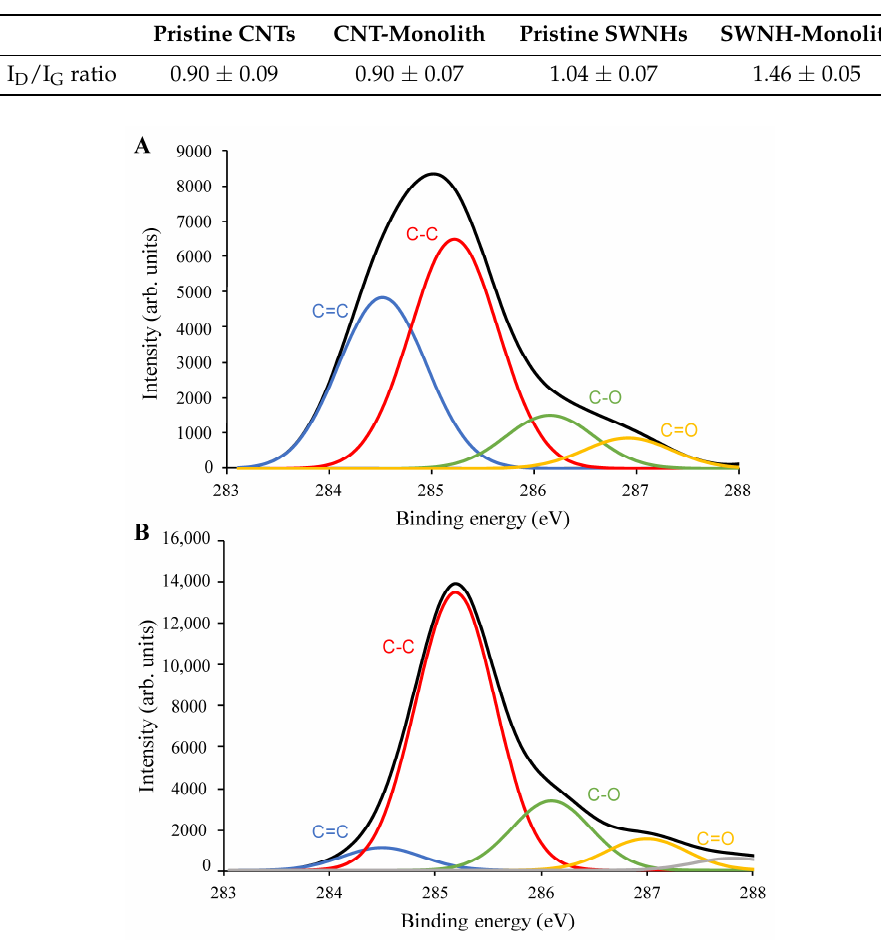
Table 2. Ratio of the intensity of the D and G band from the Raman spectra of the pristine carbon nanomaterials, namely carbon nanotubes (CNTs) and single-walled carbon nanohorns (SWNHs) and their corresponding monoliths.